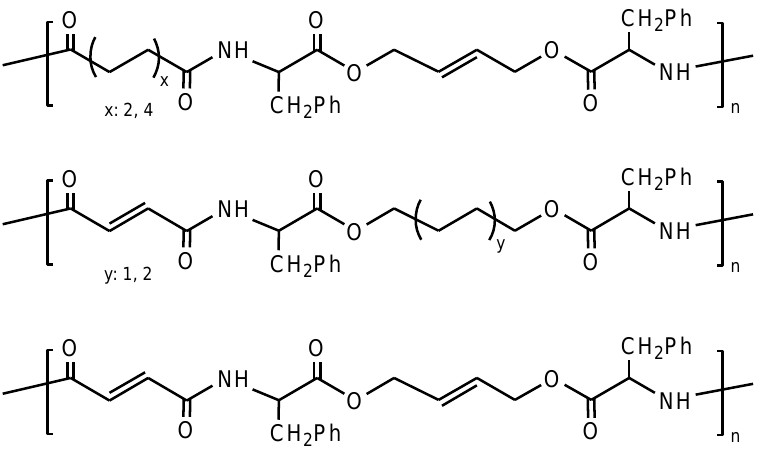
Figure 15. Chemical structure of copoly(ester amide)s with unsaturated diol and diacid units.